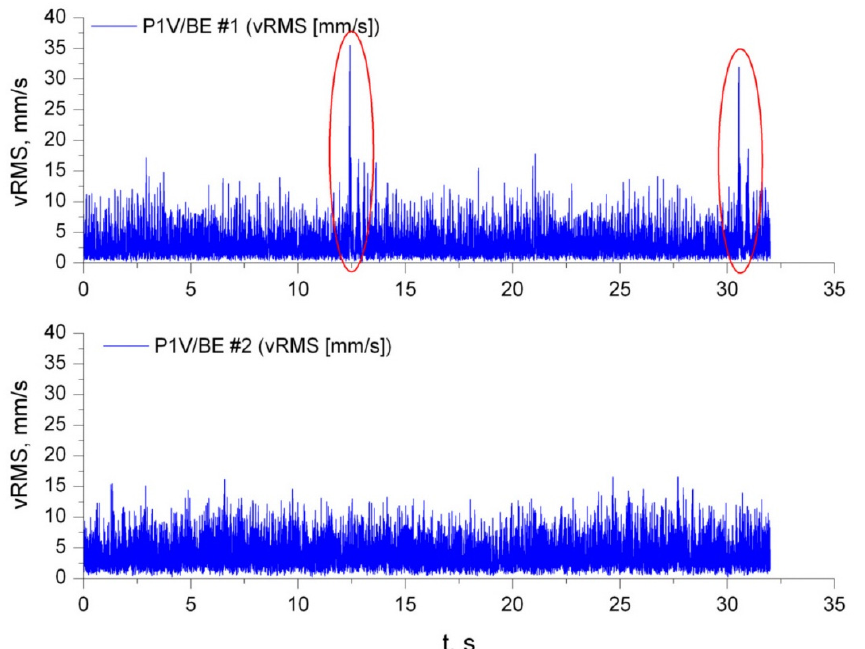
Figure 3. Time waveform of vibration velocity in the vertical direction in point P1 (on the outer bearings of the driving motors) in bucket elevators BE#1 ( upper diagram ) and BE#2 ( lower diagram ). Two extreme peaks in BE#1 are marked with red and explained below.